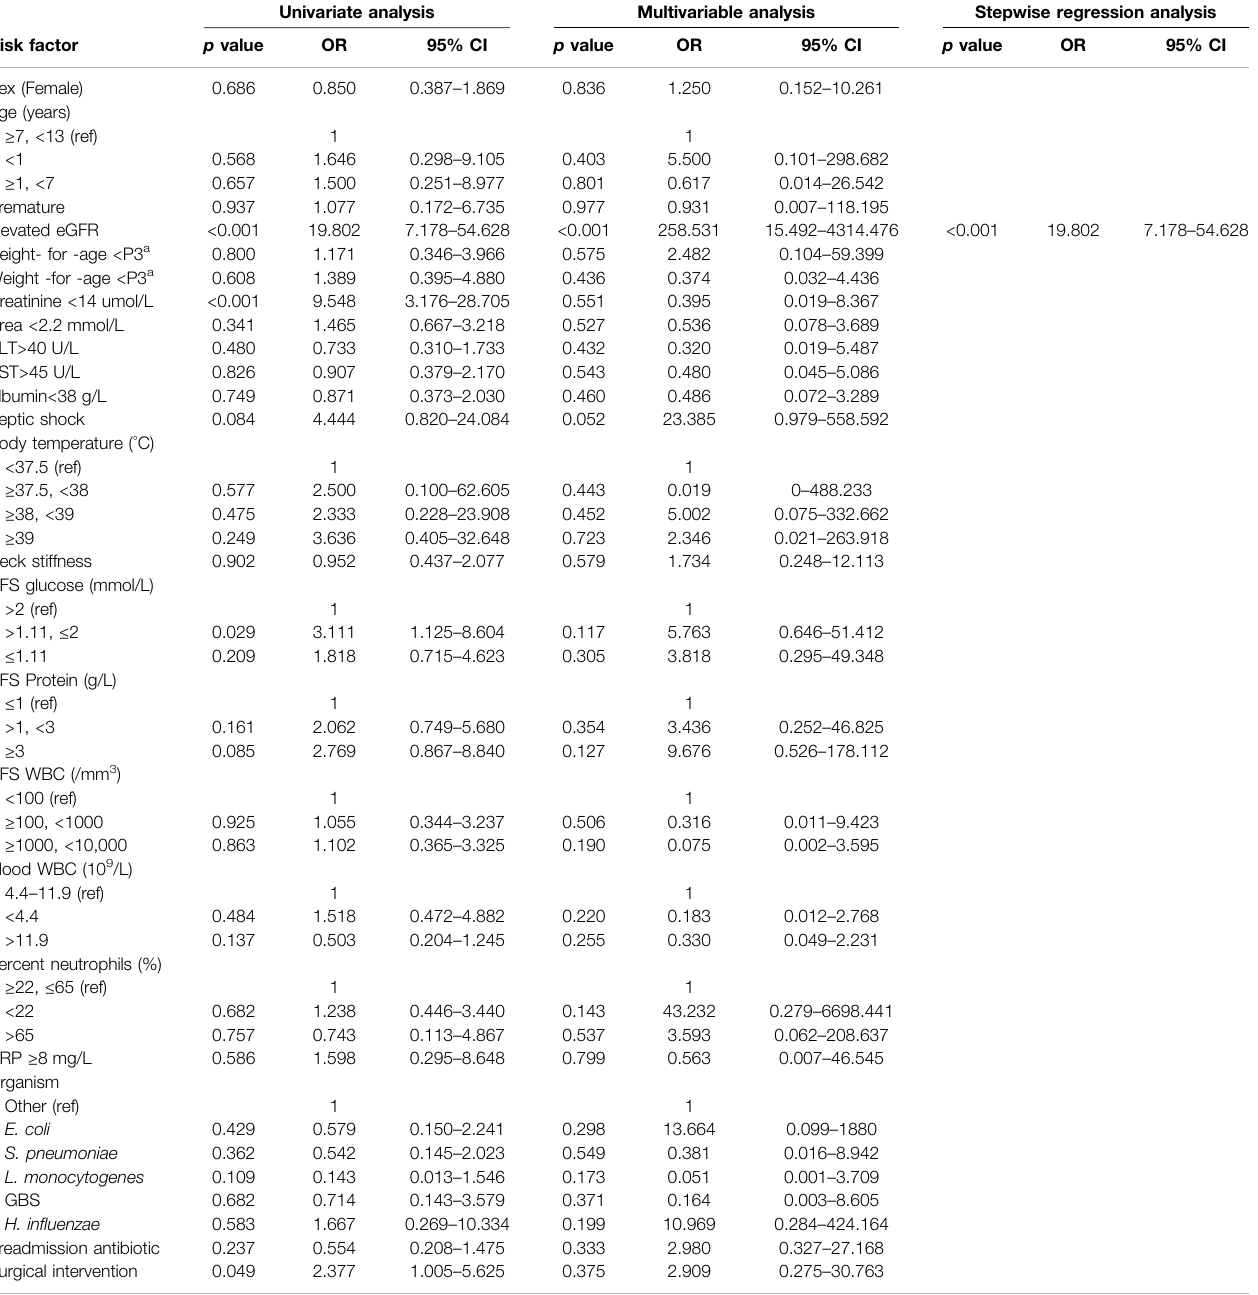
TABLE 2 | Associations between various clinical factors and prolonged antibiotic use in children with bacterial